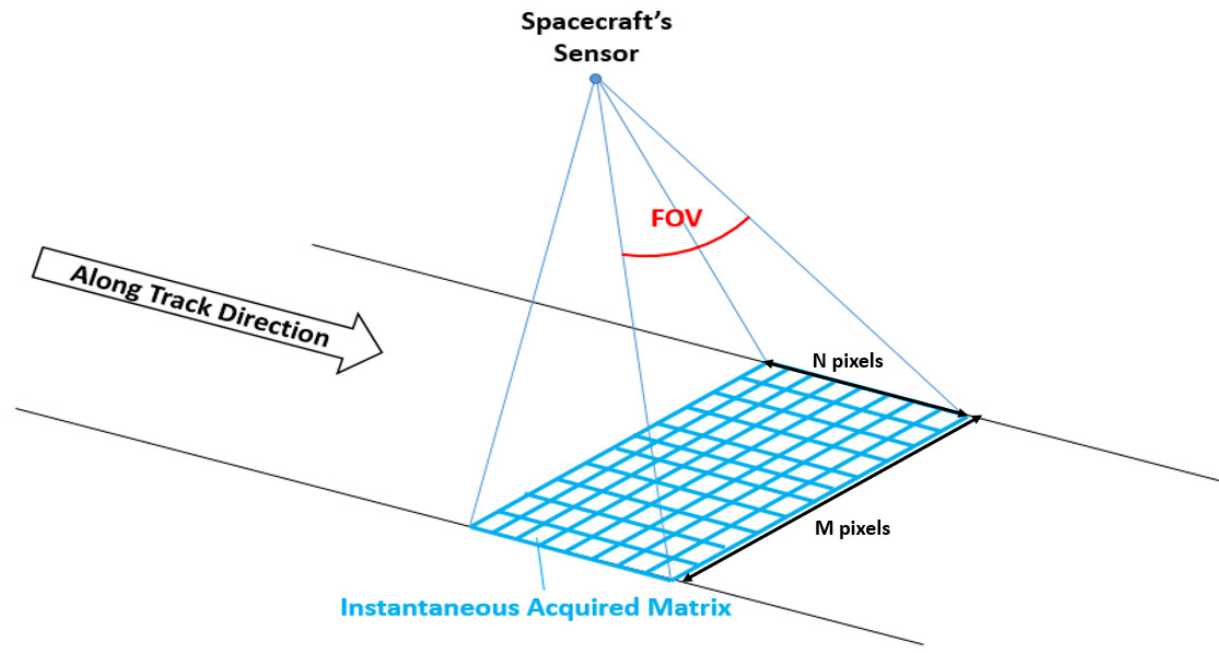
Figure 1. Acquisition geometry of a matrix imager, with HFOV aligned along-track. The information collected within each row of the sensor will be characterized by a different instantaneous field of view (iFOV) per pixel, as shown schematically in Figure 2, in which the Earth is considered as a sphere, and no scale is properly kept. This configuration ensures the required coverage, depending on the camera HFOV and the integrated number of cameras. With this implementation, observations can be obtained at as many off-nadir angles as the number N of pixel (“rows”) in the sensor